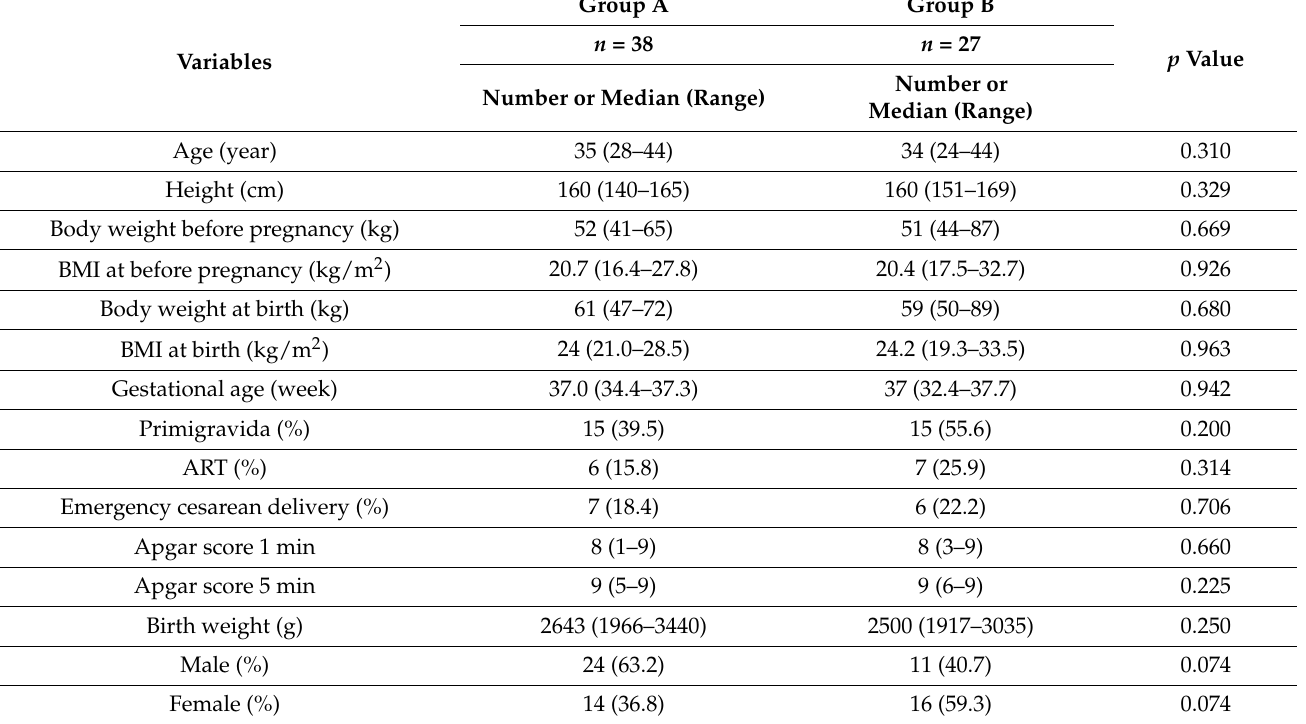
Table 1. Clinical characteristics of